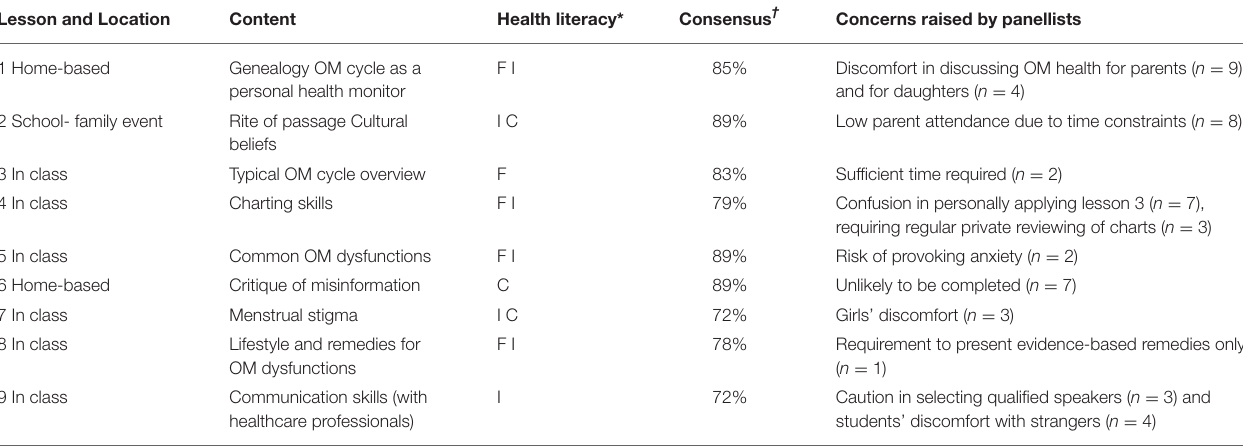
TABLE 3 | Round Two consensus of the draft OM health literacy intervention. Lesson and